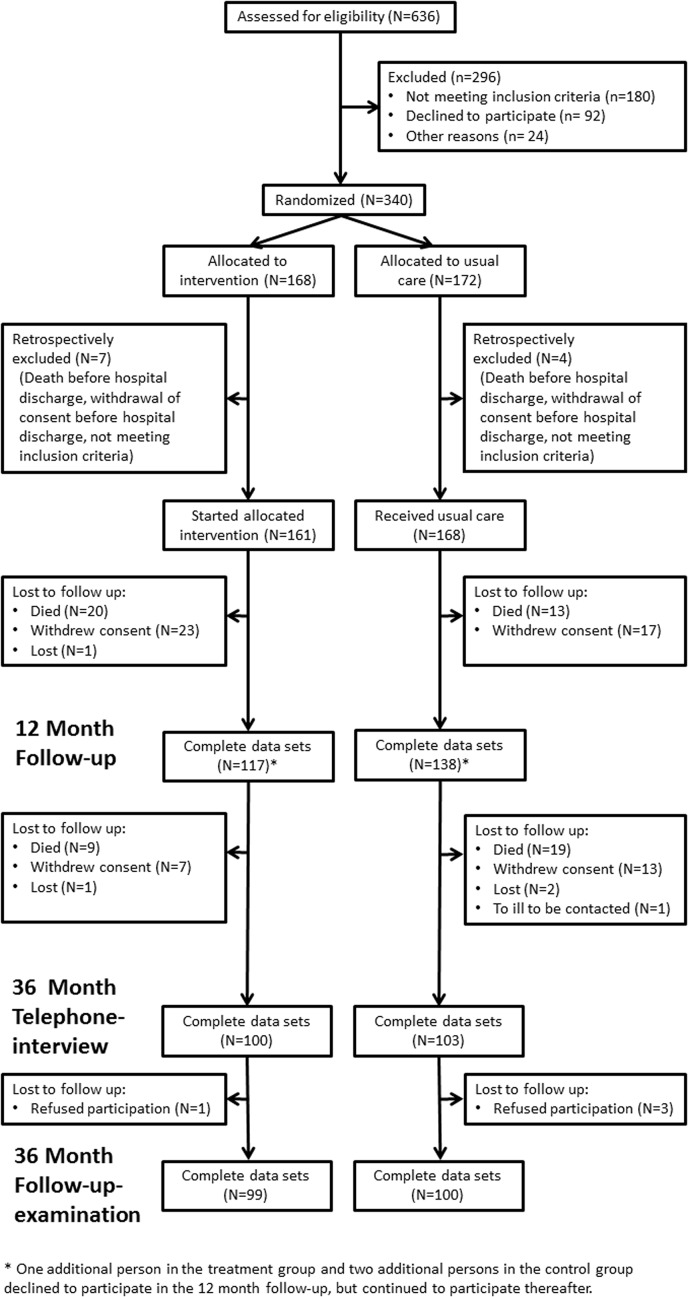
Flow of participants through the KORINNA trial.